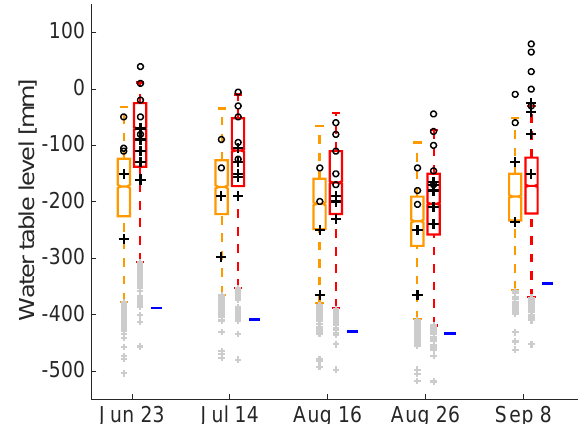
Figure 4. Box plots of simulated water table depth in hummocks (orange boxes) and hollows (red boxes) against measurements from the bog (black crosses) and from the rest of the peatland (black circles). Grey crosses are outliers in the simulation. The blue line represents the output of the model without representation of micro- topography. The box plot parameters regulating the length of the whiskers are the default values for covering 99 . 3% of the data if the data are normally